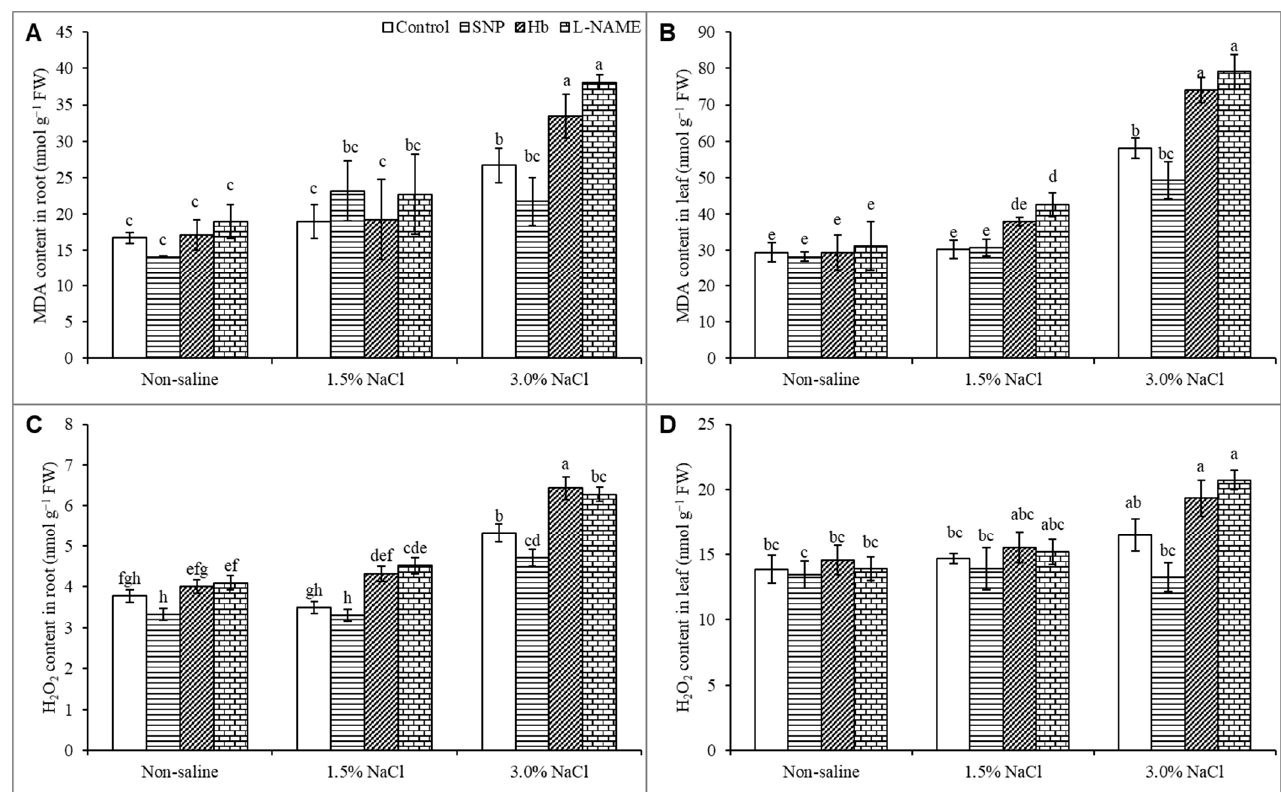
Figure 6. MDA content ( A , B ) and H 2 O 2 content ( C , D ) in roots and leaves of Kandelia obovata treated with different salt concentrations and with 100 µM sodium nitroprusside (SNP, a NO donor), hemoglobin (Hb, a NO scavenger), or N ω -nitro- L -arginine methyl ester ( L -NAME, a NO synthase inhibitor). Mean (± SD) was calculated from three replicates for each treatment. Bars with different letters are significantly different at p ≤ 0.05, applying Tukey’s HSD test.